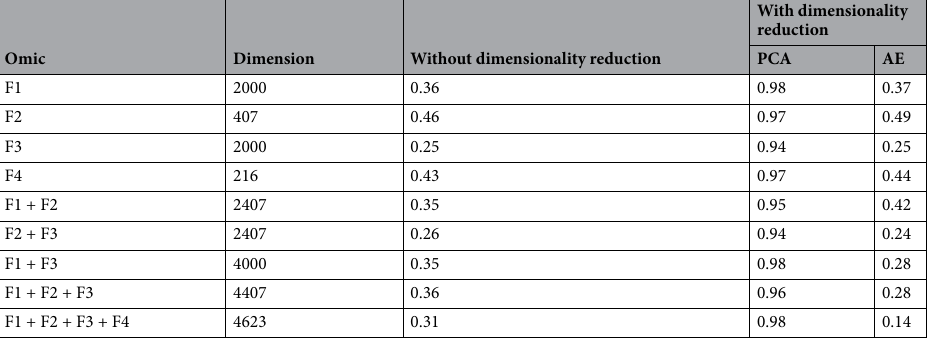
Table 1. Summarizing the PAC values obtained for K = 5 for each level of evidence for the subset of selected features, when clustered without dimensionality reduction, and with dimensionality reduction using PCA and AE (F1: mRNA (PcGs) expression, F2: miRNA expression, F3: DNA methylation, F4: protein